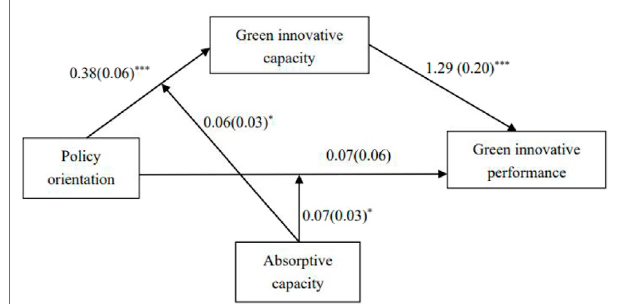
FIGURE 2 | Results of structural